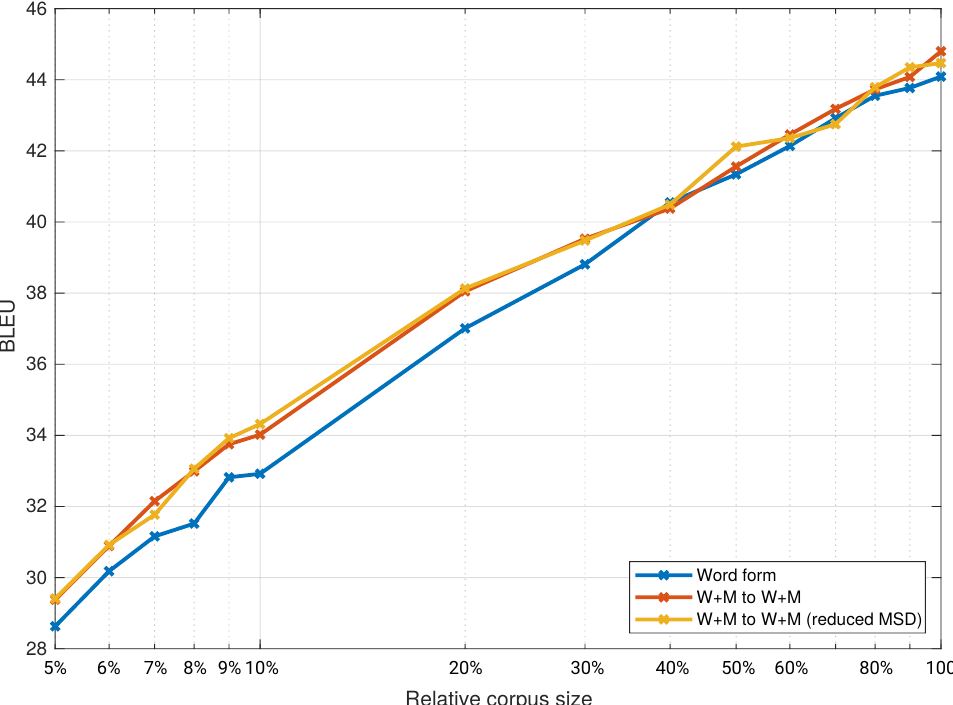
Figure 3. Translation results for the selected translation systems from English to Slovene using ParaCrawl with respect to relative training corpora size.